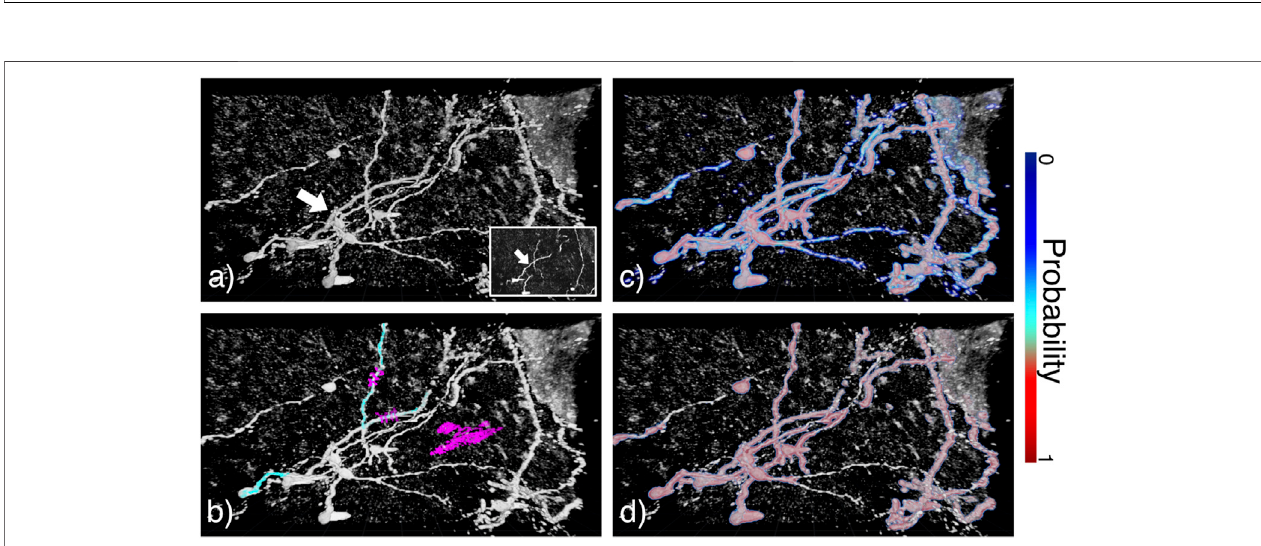
FIGURE7| AnnotationinDIVAonconfocalmicroscopyimagesofmouse olfactory bulbinterneurons(white arrow). (A) Rawdatavisualizedin3DonDIVAand asa z-stackinthebottomrightcorner. (B) Overlayofrawdataingrayandtaggingdatawithpositiveandnegativetagsrespectivelyincyanandmagenta. (C,D) Overlayofraw data in gray and output probabilities respectively for RFC and strong learner. Colorscale for probabilities is indicated on the right of the image.